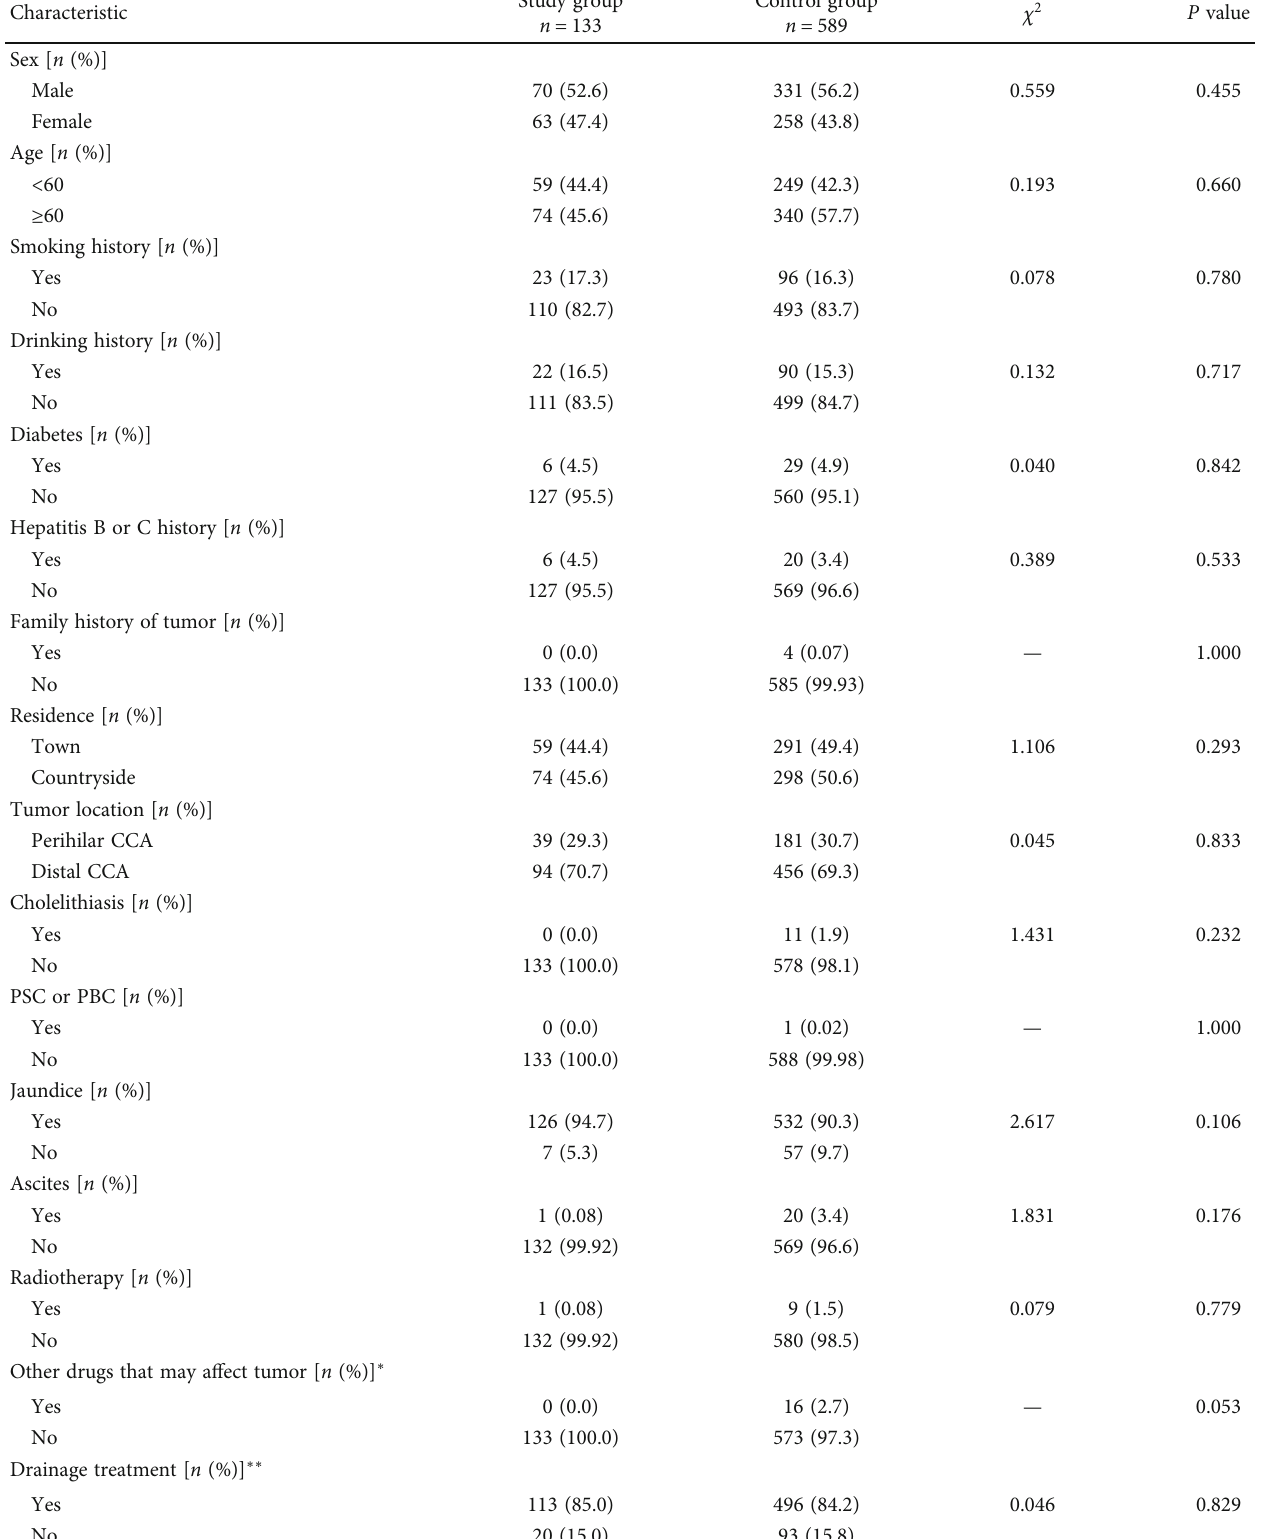
Table 1: Baseline characteristics of the study and control groups [ n